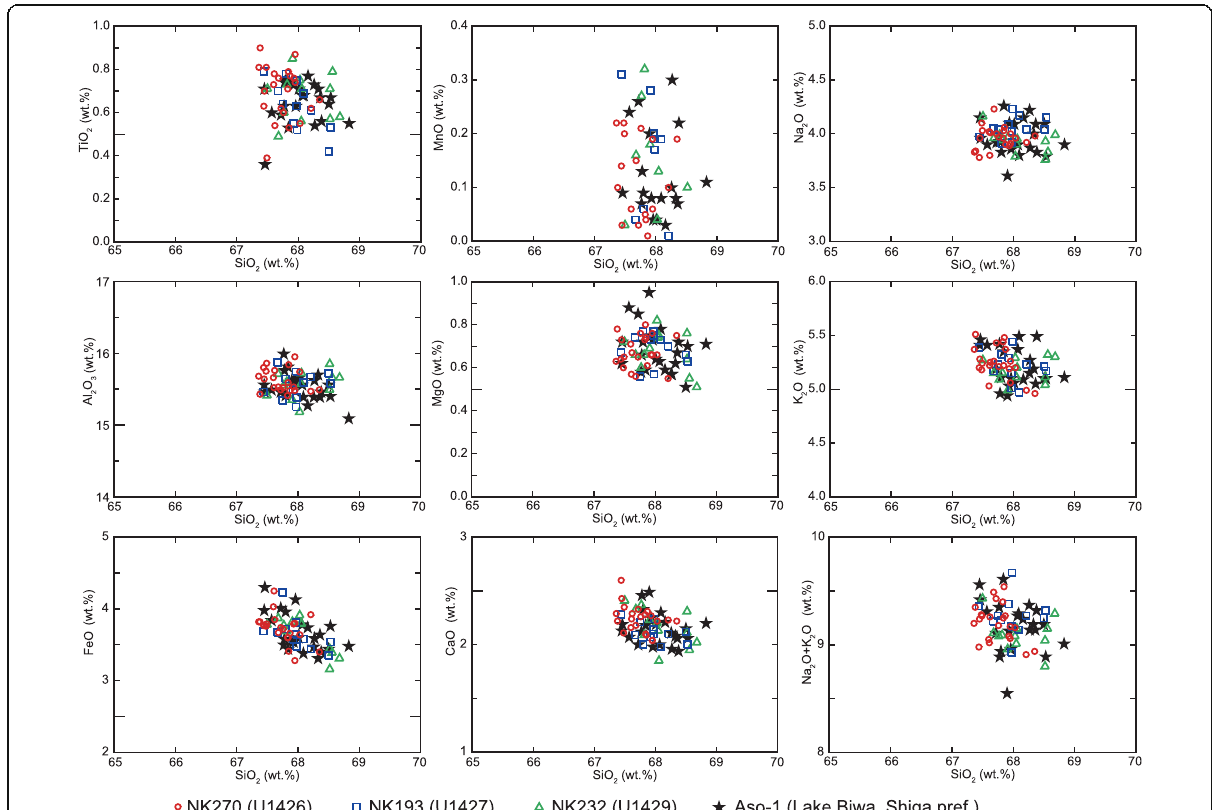
Fig. 3 Example of the Harker diagrams for correlative tephra samples from Sites U1426 (NK270), U1427 (NK193), U1429 (NK232), and the Aso-1 tephra in Lake Biwa